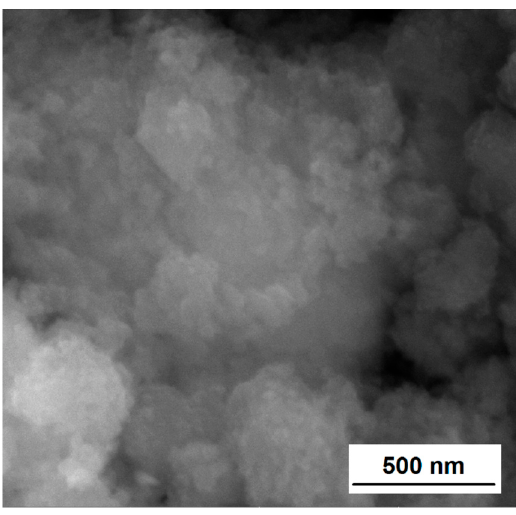
Figure 4. SEM of CuFeS 2 /TiO 2 nanocomposite.